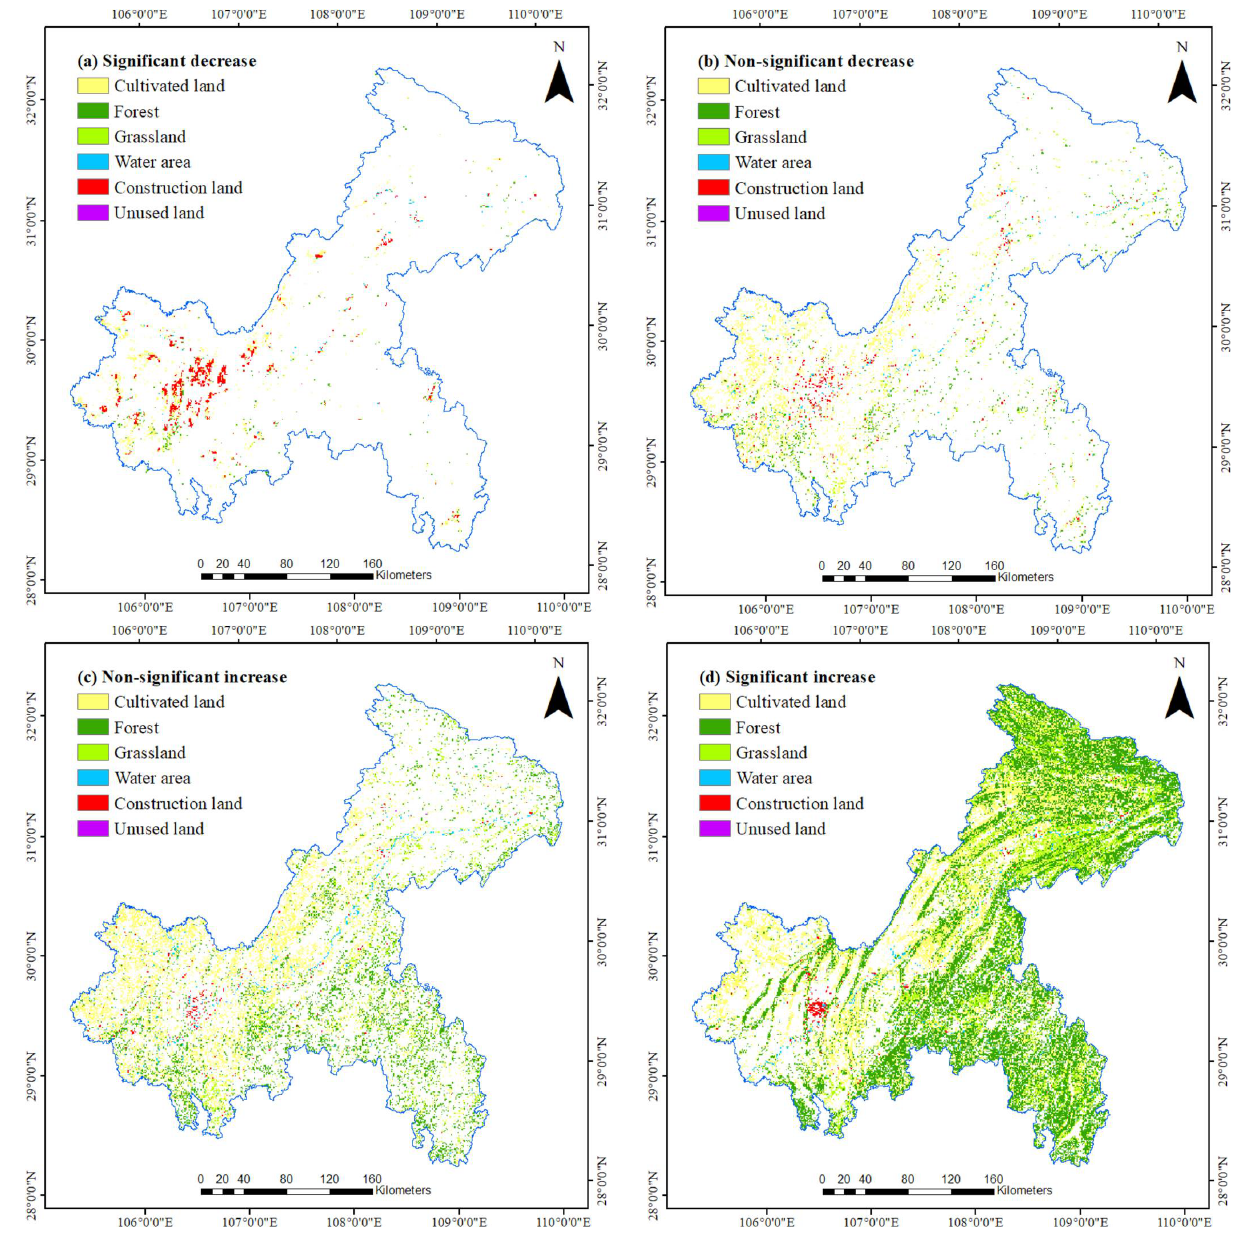
Figure A5. Spatial distribution of land use types in different regions in 2020: ( a ) significant decrease, ( b ) non-significant decrease, ( c ) non-significant increase, and ( d ) significant increase.